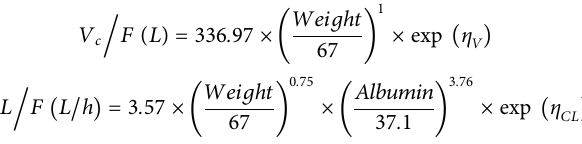
(Table 2) ( △ OFV = − 33.1, p < 0.01). Age, sex, and height had no